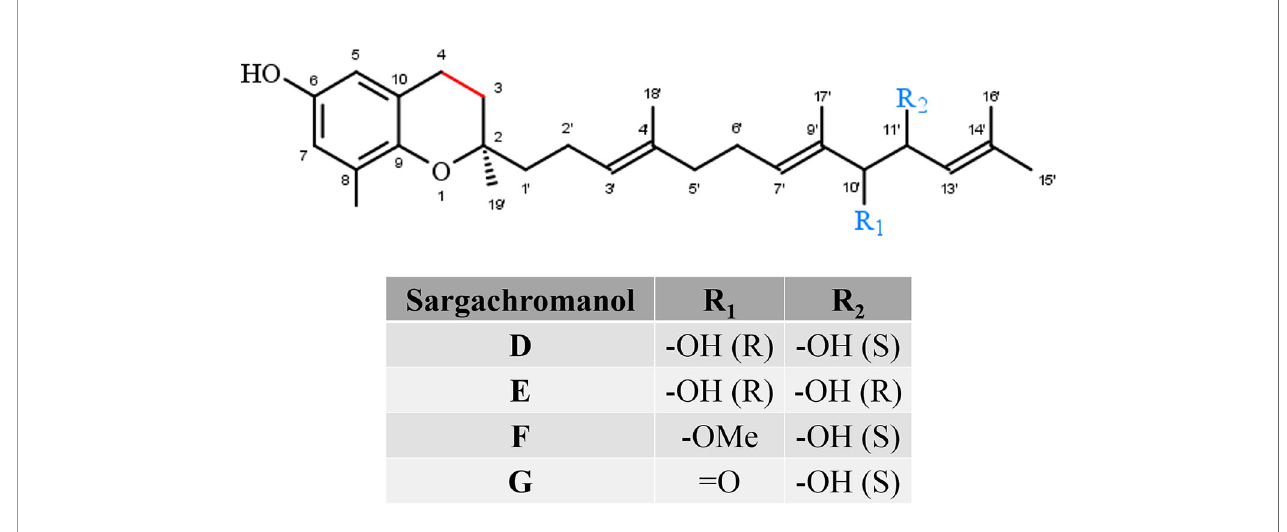
FIGURE 4 | Core structure of sargachromanol